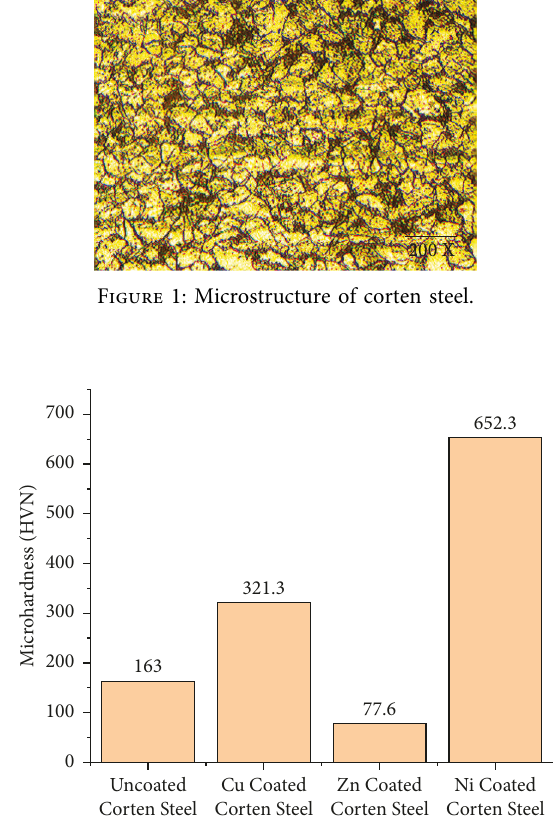
Figure 2: Microhardness of uncoated and coated corten steel